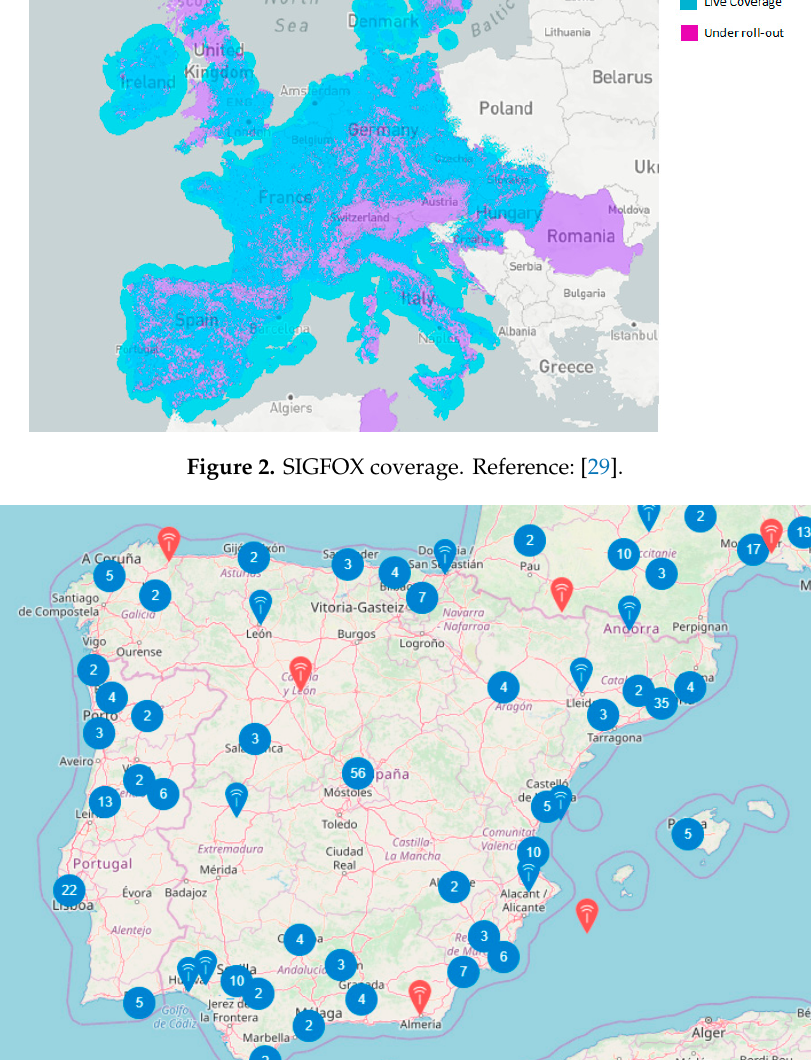
Figure 2. SIGFOX coverage. Reference: [29].